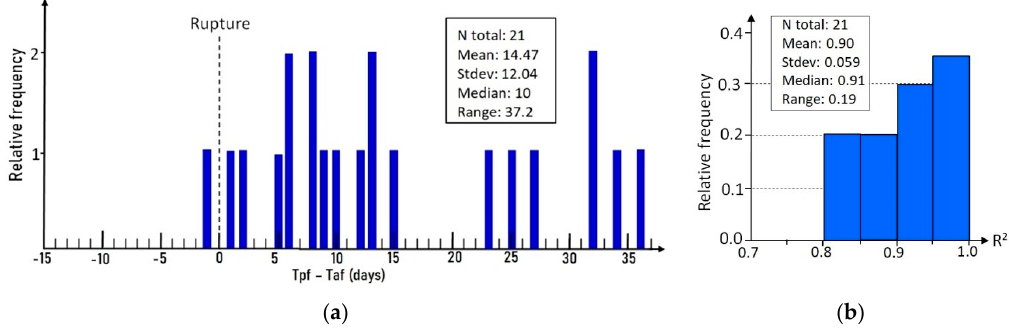
Figure 13. SBAS relative frequency distribution of the errors ( a ) and R 2 coefficient from the inverse velocity predictions ( b ).